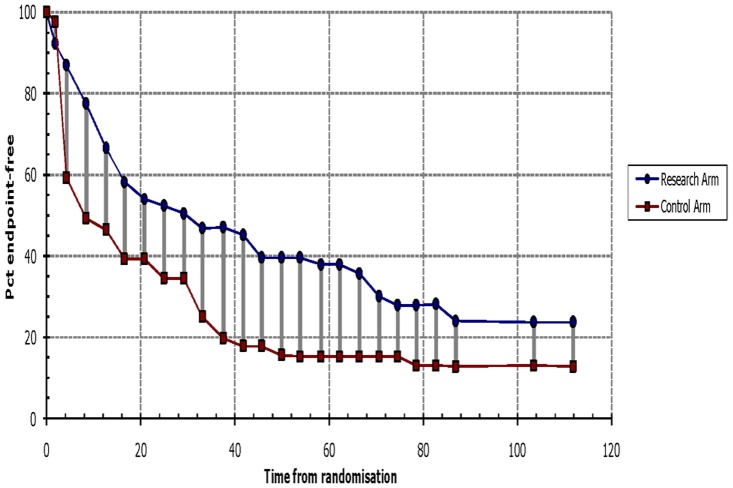
Survival data for overall survival based on Kaplan-Meier curve by Tierney’s method from Chau GY’ study.The survival data read from Kaplan-Meier curves by Engauge Digitizer version 4.1were entered in the spreadsheet appended to Tierney’s paper, then we got this figure and HR value. It is similar to the orignal graph, see figure S1.